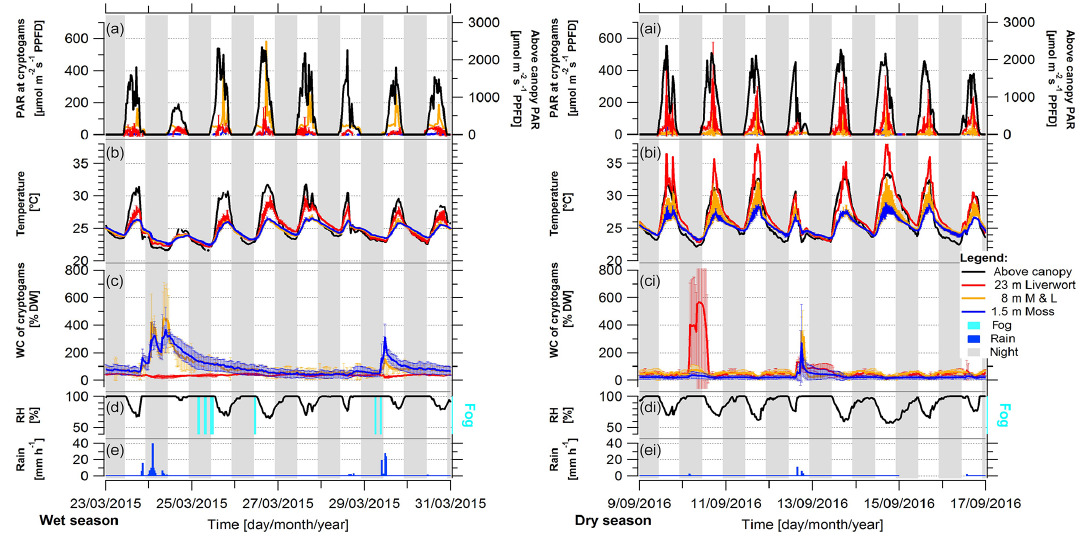
Figure 2. Representative periods during the wet and dry season under average conditions, showing light condition (PAR), temperature, and water content (WC) of bryophytes, and above-canopy meteorological conditions in the Amazonian rain forest. Shown are 8d periods during (left) the wet season 2015 and (right) the dry season 2016. The micrometeorological parameters on top and within epiphytic cryptogamic communities represent (a, a i ) the photosynthetically active radiation (PAR) on top, (b, b i ) the temperature within, and (c, c i ) the WC of cryptogamic communities. The above-canopy meteorological parameters comprise (a, a i ) above-canopy photosynthetically active radiation (PAR at 75m), (b, b i ) above-canopy temperature (at 26m), (d, d i ) relative air humidity (RH at 26m height), presence of fog events, and (e, e i ) rain amount. The data show 30min averages ± SD except for rain, which shows hourly sums. Data of replicate sensors installed within communities at the same height level were pooled, while above-canopy parameters were measured with one sensor each. The nighttime is shaded in gray (18:00–06:00LT).